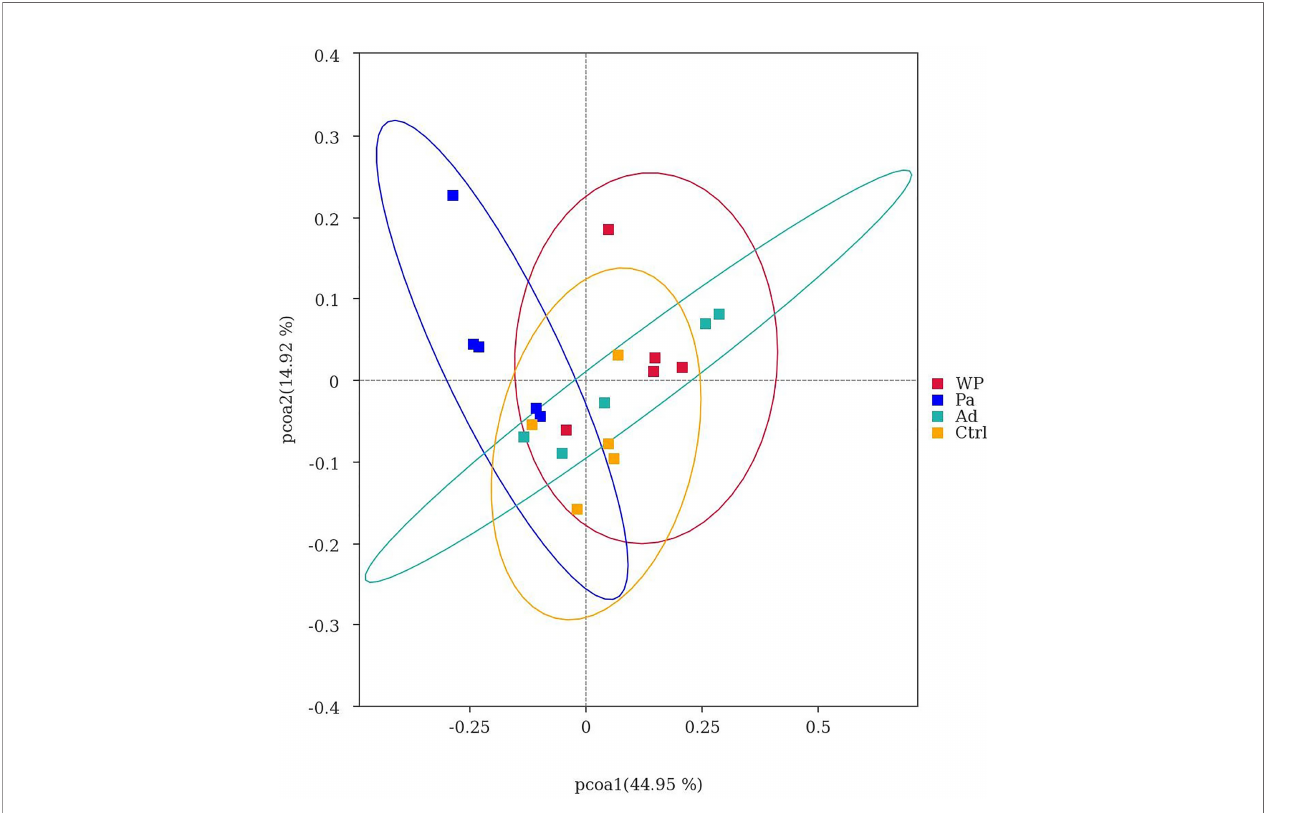
FIGURE 7 | Principal co-ordinate analysis of different